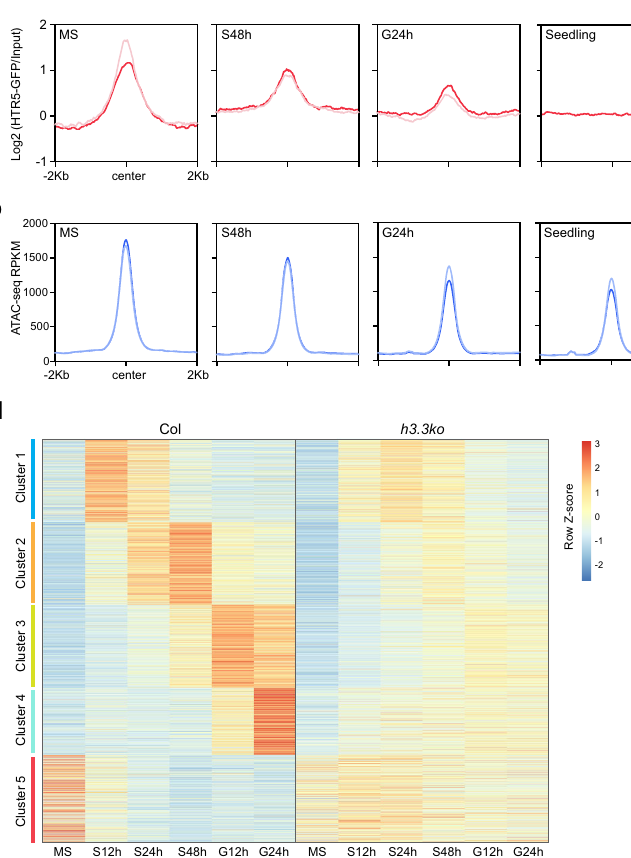
accessibility signi fi cantly decreased regions in mature h3.3ko seeds compared with Col.Genesweregroupedinto fi veclustersbasedontheirexpressionpatternsduring imbibition in Col. e GO analysis of genes associated with accessibility signi fi cantly decreased regions in mature h3.3ko seeds compared withCol. Top 15 representative terms are listed and ranked by P value, which was calculated with hypergeometric test. f Metaplot of ATAC-seq signals in imbibed Col and h3.3ko seeds over accessi- bility signi fi cantly increased regions in mature h3.3ko seeds compared with